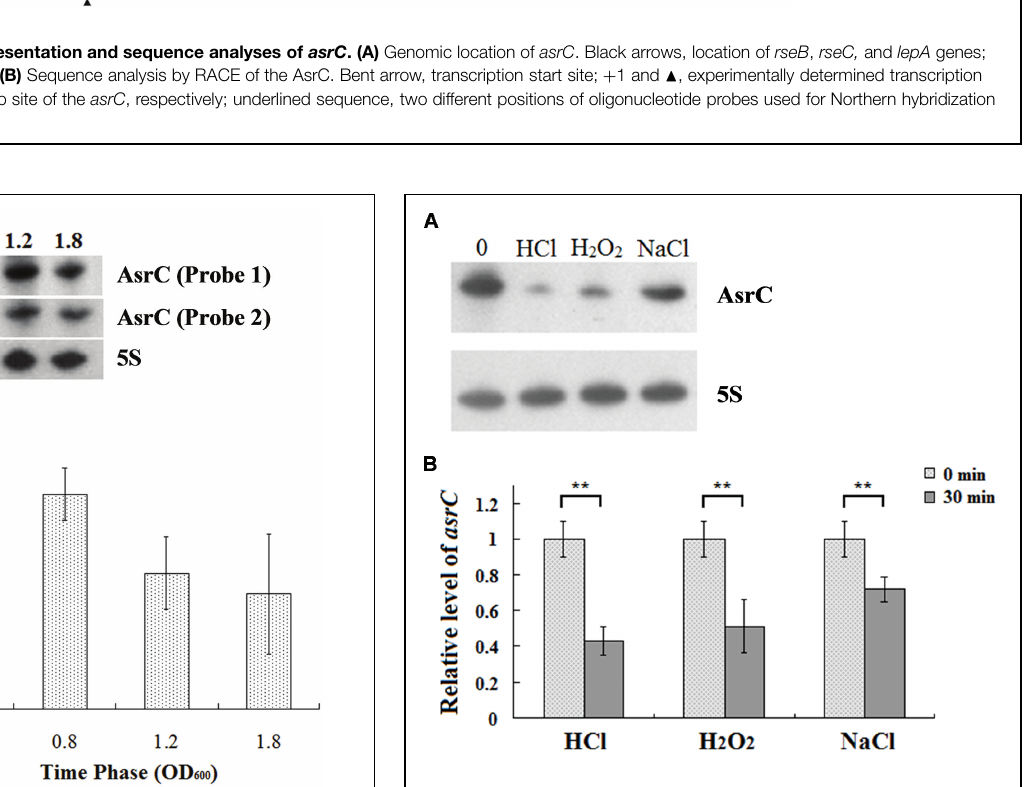
FIGURE 3 | Expression of AsrC under stress conditions. (A) Northern hybridization and (B) qRT-PCR of total RNA isolated from Salmonella typhi cells grown in LB to OD 600 0.4 and subjected for 30 min to acid stress (HCl: pH 4.5), oxidative stress (H 2 O 2 : 4 mM hydrogen peroxide) or osmotic shock (NaCl: 0.3 M NaCl). Internal reference was 5S rRNA. ∗∗ P < 0.01 compared with control